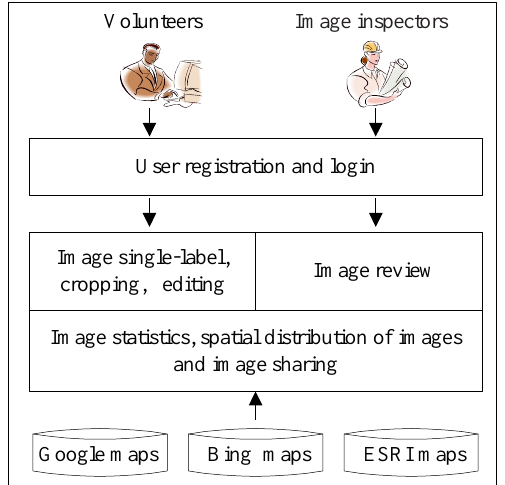
Figure 1. Conceptual architecture of the V-RSIR tool